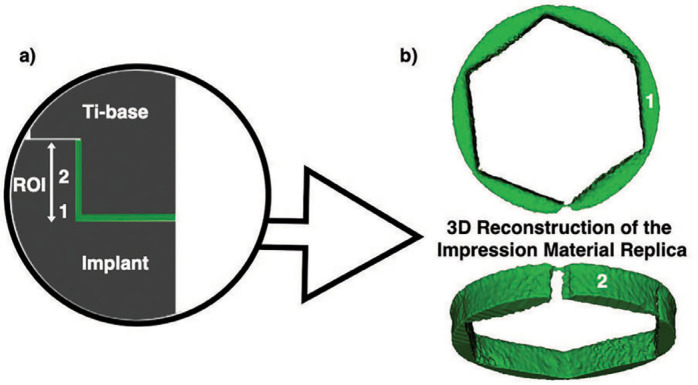
Schematic illustration of the silicone impression material inserted into the implant (a). To determine similar volume analysis across groups, the region of interest (ROI) was defined by cropping the replica image from the implant platform to the hexagon height. ROIs for linear marginal (1) and central (2) measurements are also depicted. 3D reconstruction of the gap replica (b)